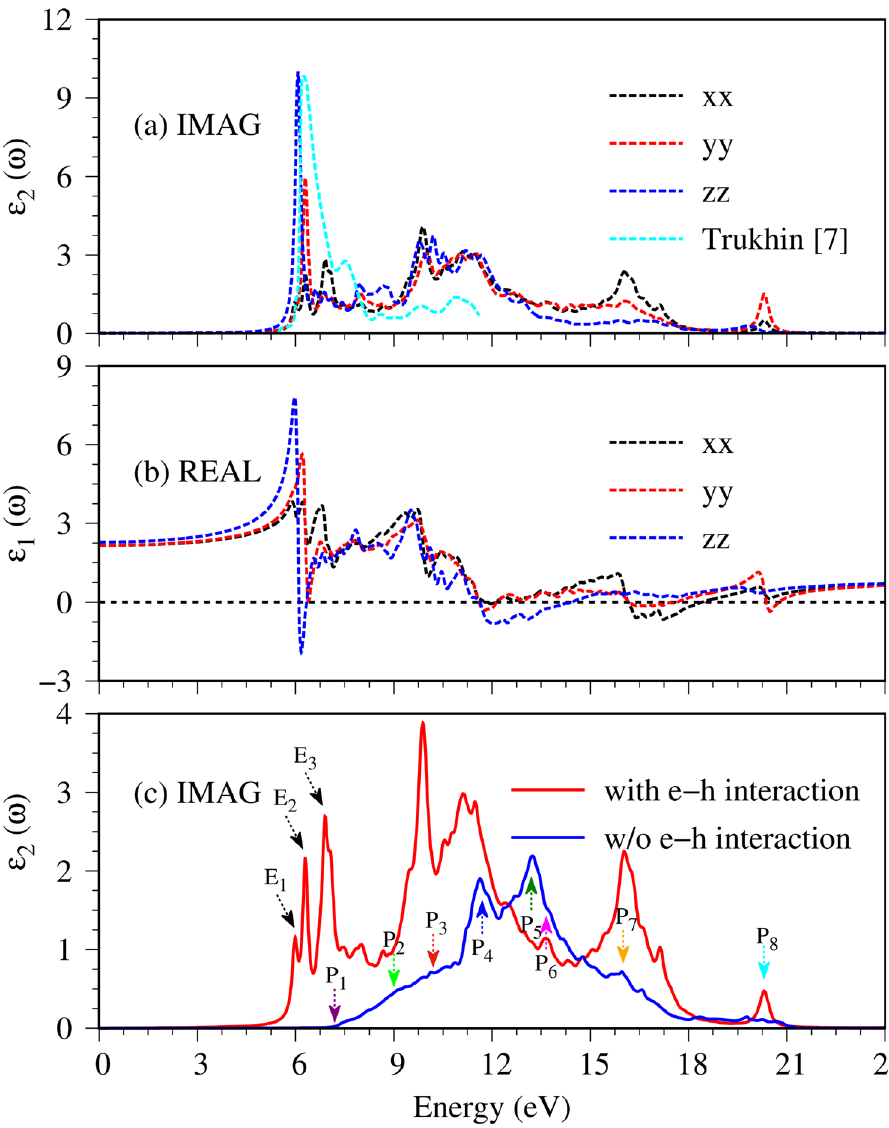
Figure 5. ( a ) The imaginary and ( b ) real parts of dielectric functions with the excitonic effects under three electronic-polarization directions (The dash black, red and blue lines). The previous experiments result (the dash cyan line) is also added. ( c ) Comparison of the imaginary parts of the dielectric function of x-direction with and without excitonic effects. The independent-particle optical absorption and the three first exciton peaks are, respectively, made with colored and black